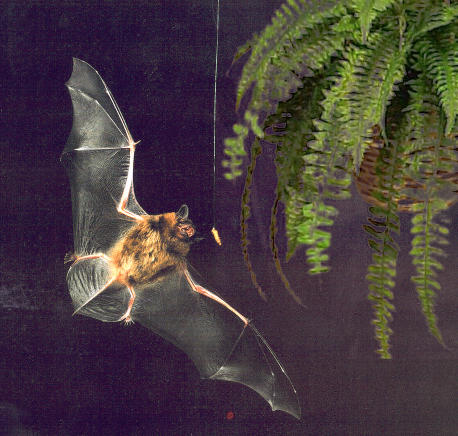
Echolocating bats adjust their vocalizations to catch insects against a changing environmental background.